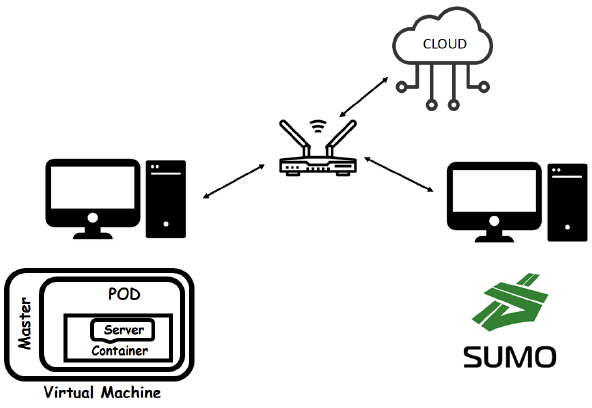
Figure 7. Considered